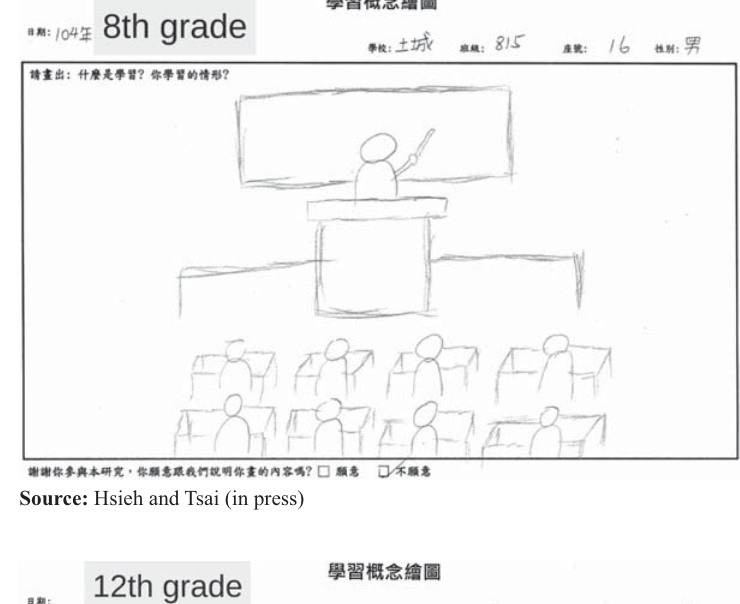
Source: Hsieh and Tsai (in press)